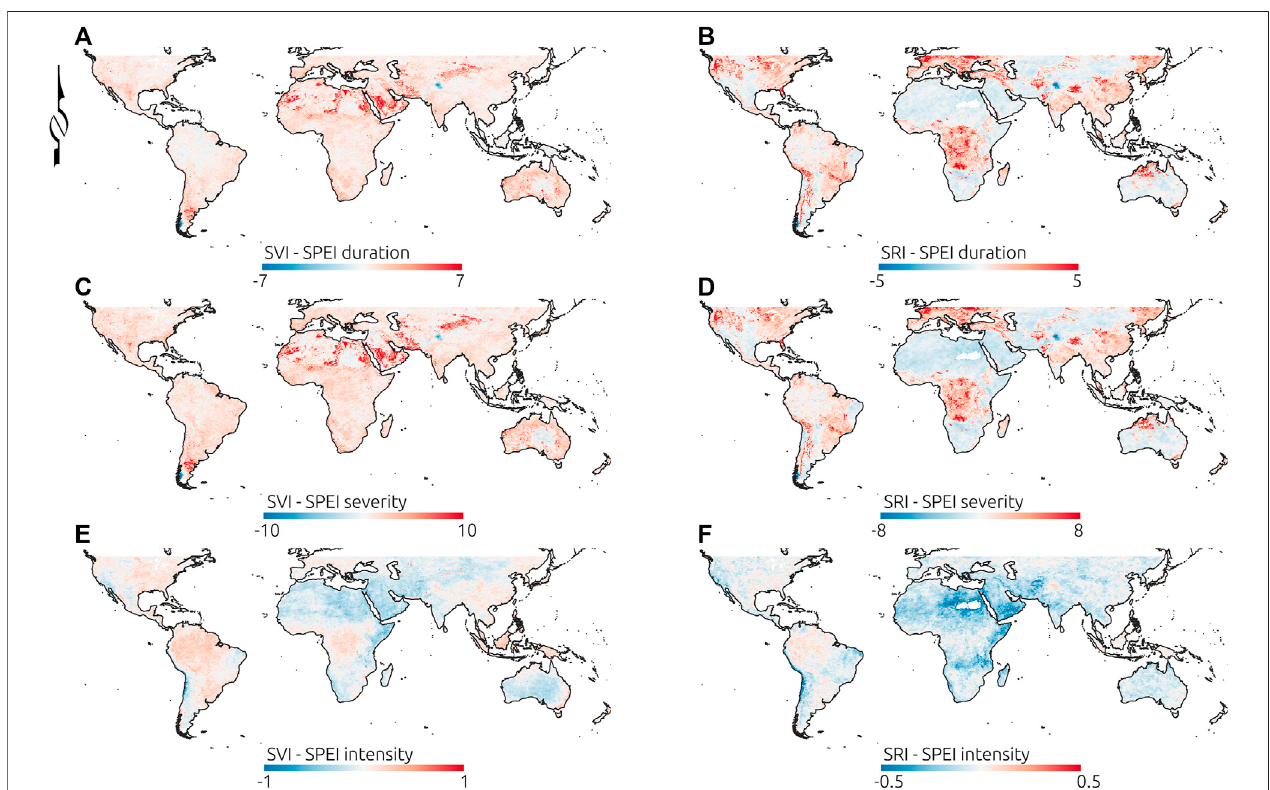
FIGURE 10 | Duration (A,B) , severity (C,D) and intensity (E,F) mean differences between SVI and SPEI (A,C,E) and between SRI and SPEI (B,D,F) .